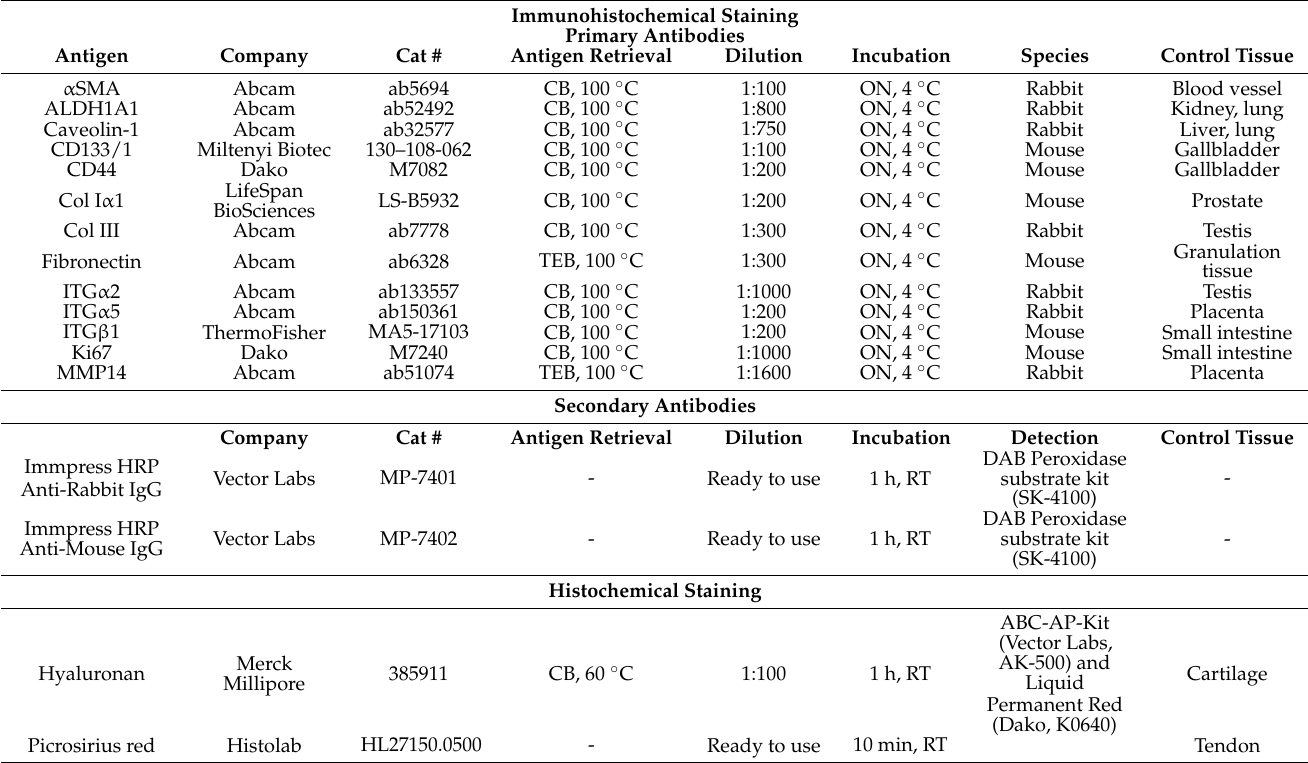
Table 4. Antibodies and procedures for immunohistochemical and histochemical